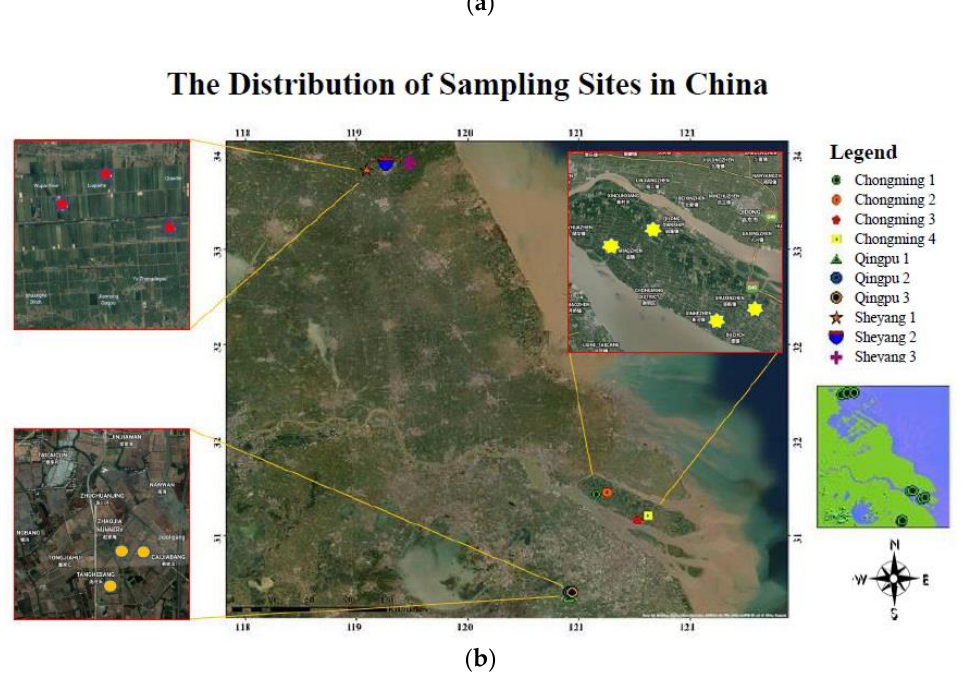
Figure 1. The distribution of sampling sites: ( a ) rice and soil sampling sites in Thailand, ( b ) rice and soil sampling sites in China.